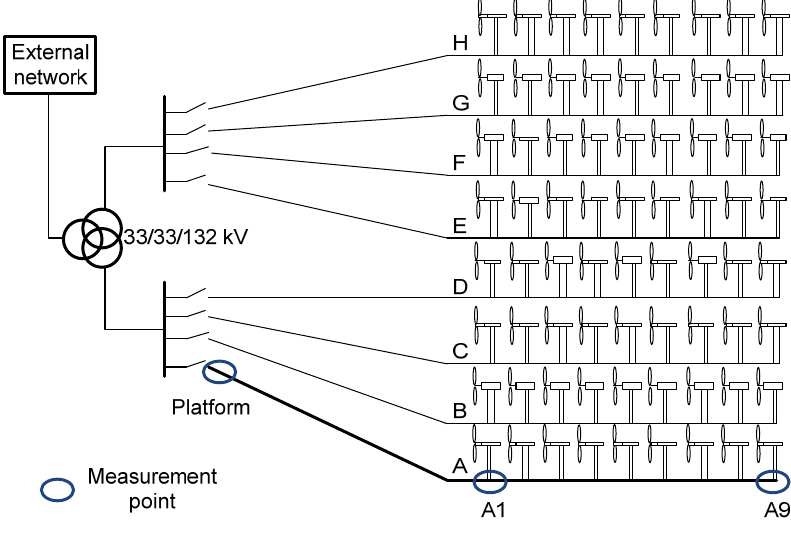
Figure 1. Schematic of the Nysted Offshore Wind Farm. The three locations where the measurement system was installed during the transient measurement campaign are also indicated.